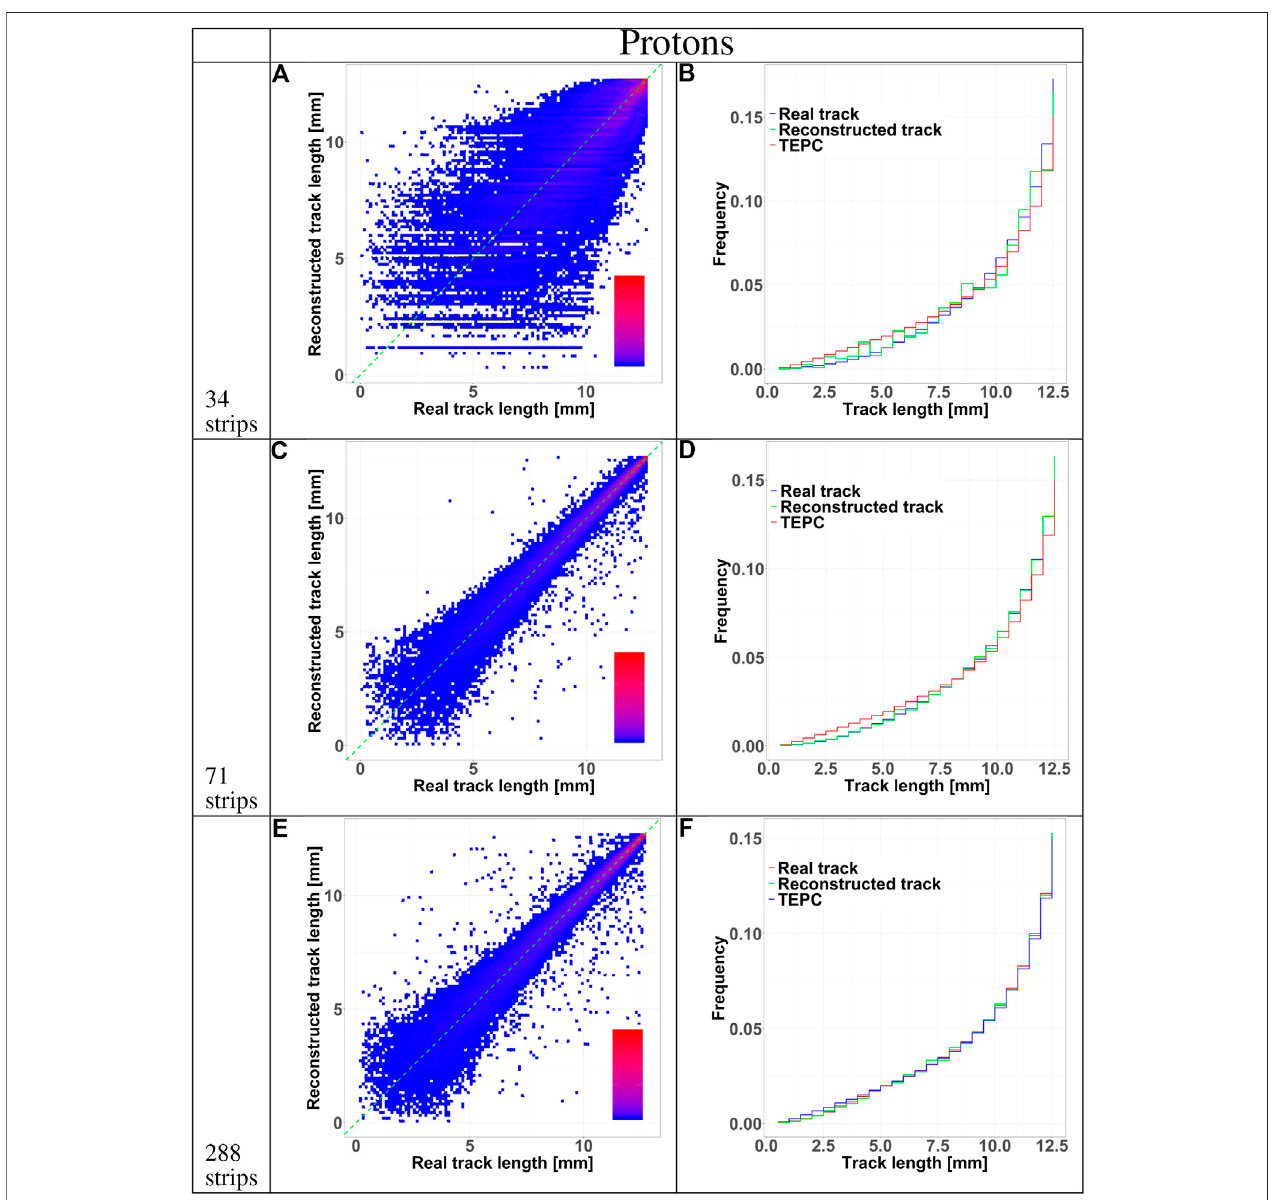
FIGURE 5 | HDM performances when exposed to 150 MeV protons at 10.74 cm depth in water. The results are shown for 34, 71, and 288 strips LGAD con fi gurations. Panels (A) , (C) , and (E) shows 2D color plots of track length obtained with HDM vs. real track length calculated directly with Geant4. The green dashed line at 45 degrees indicates the perfect agreement between the two datasets. The colors represent regions with a high (red) or low (blue) density of events. Panels (B) , (D) , and (F) illustrate the comparison between the track length distributions of particles tracked by HDM considering the real track lengths calculated with Geant4 (blue line) or that reconstructed with the tracking algorithm (green line). The distributions of the real track lengths obtained directly from the simulation is also shown (red